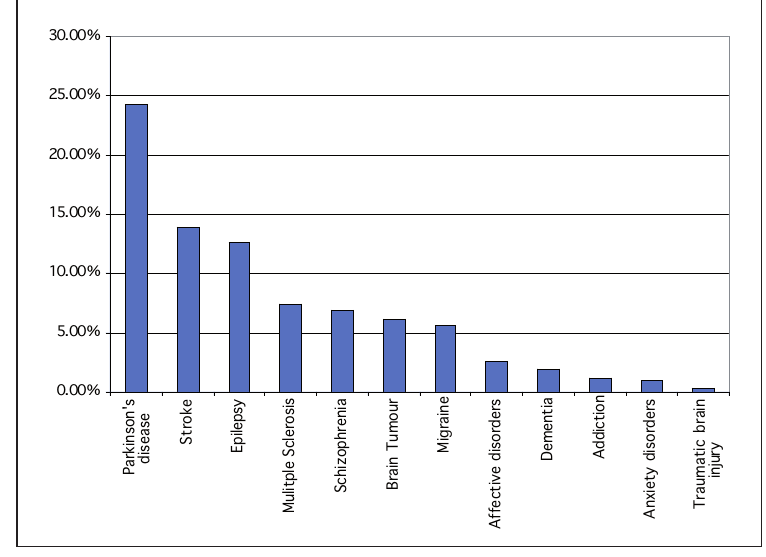
Brain research funding as percentage of costs in Switzerland